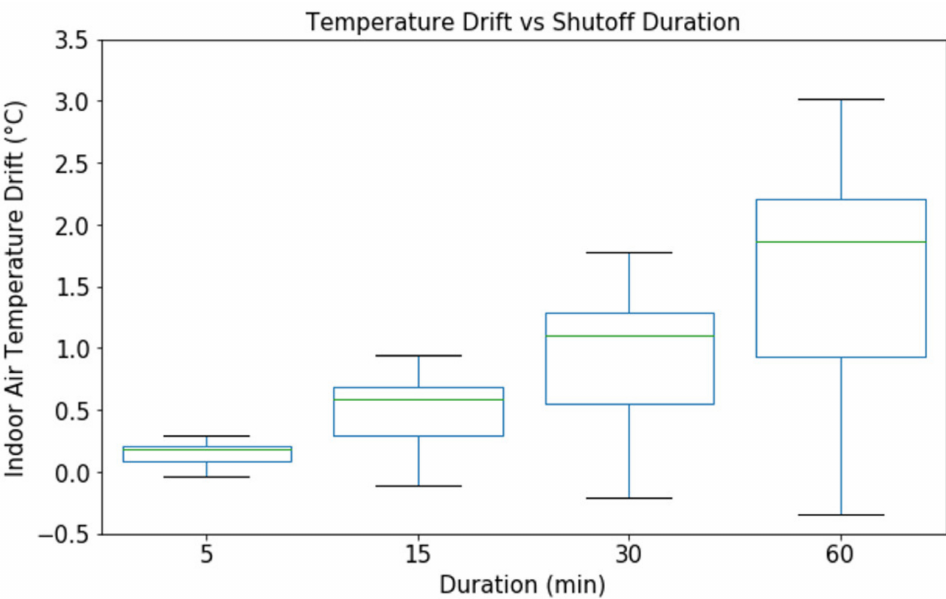
Figure 9. Box and whisker plot of internal air temperature drift vs. shutoff duration for all scenarios, with median represented by green horizontal line.